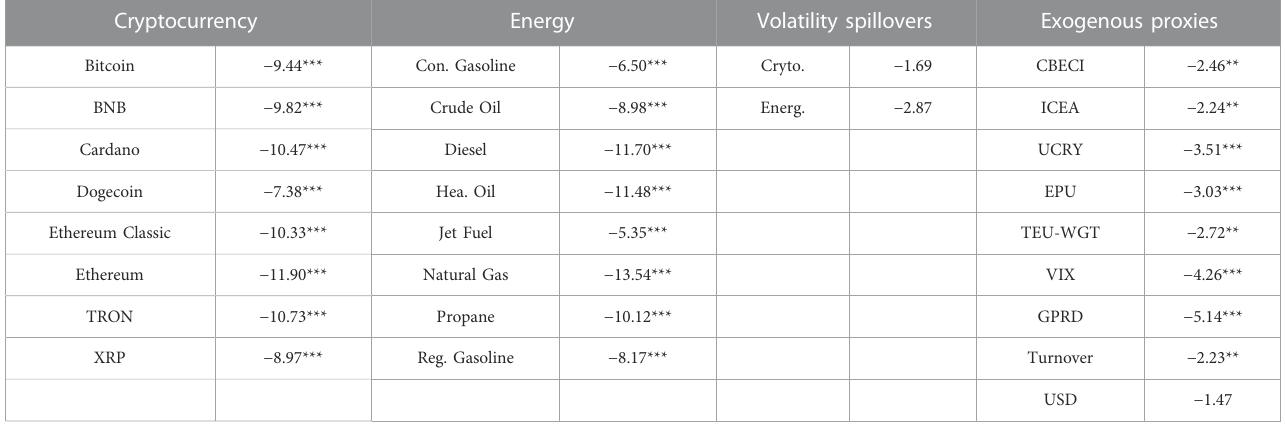
TABLE A3 Unit root test on the series in empirical